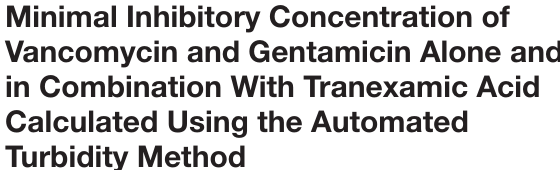
TABLE 2 | MIC 50 for vancomycin and gentamicin alone and in combination with tranexamic acid (TXA) using the automatized turbidity method. Treatment